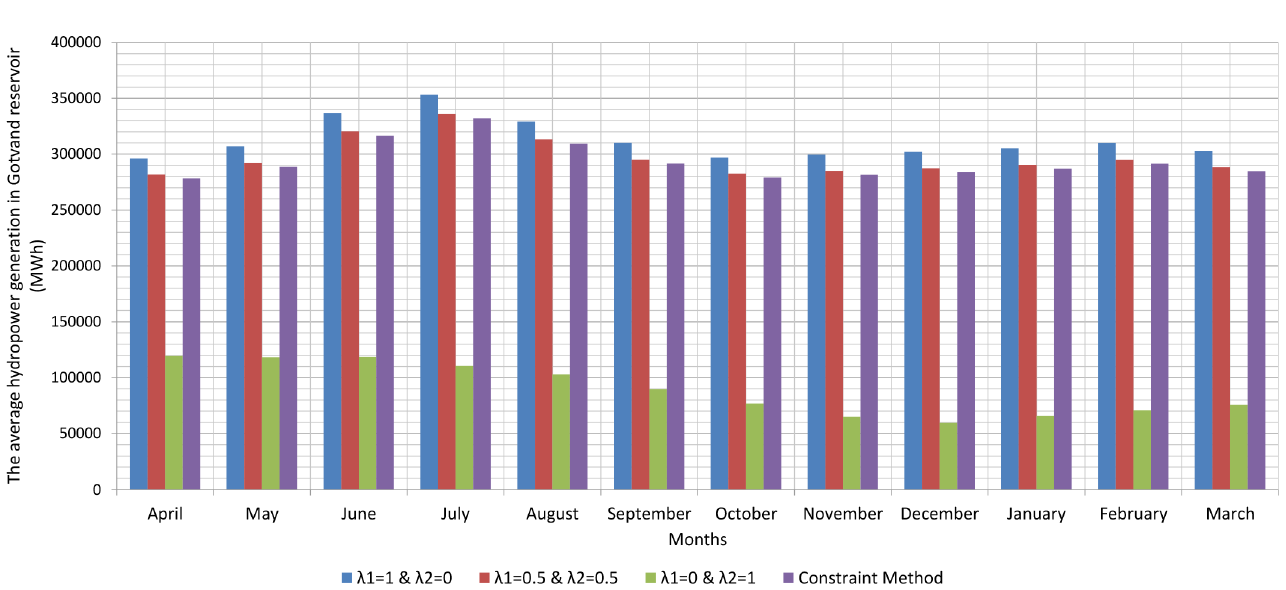
Fig 3. The average hydropower generation in Gotvand reservoir